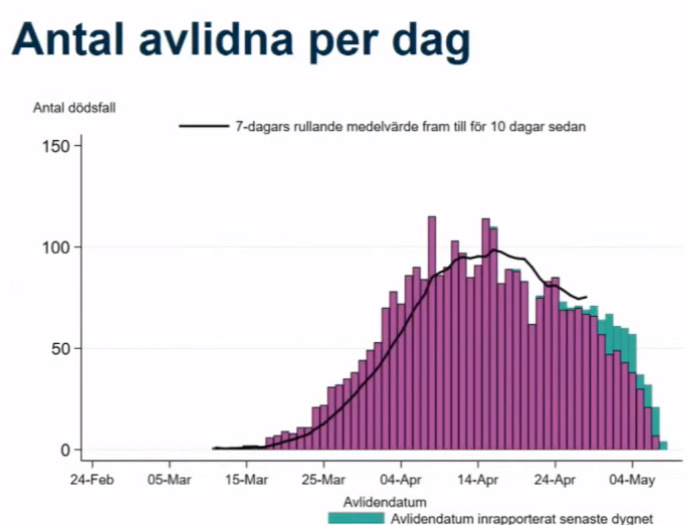
Figure 1. Screenshot from the daily press conference on 8 May by the Swedish Public Health Agency. The headline translates to “Number of deceased per day”. The bars show the number of deceased individuals who have been reported so far, assigned to their true date of death. The sections colored green show those who have been reported dead within the last 24 hours, while purple-colored bars represent earlier reported deaths. A 7-day rolling average of daily deaths is plotted as a black line. It stops on April 28, 10 days before the relevant date, because of the delay in reporting.